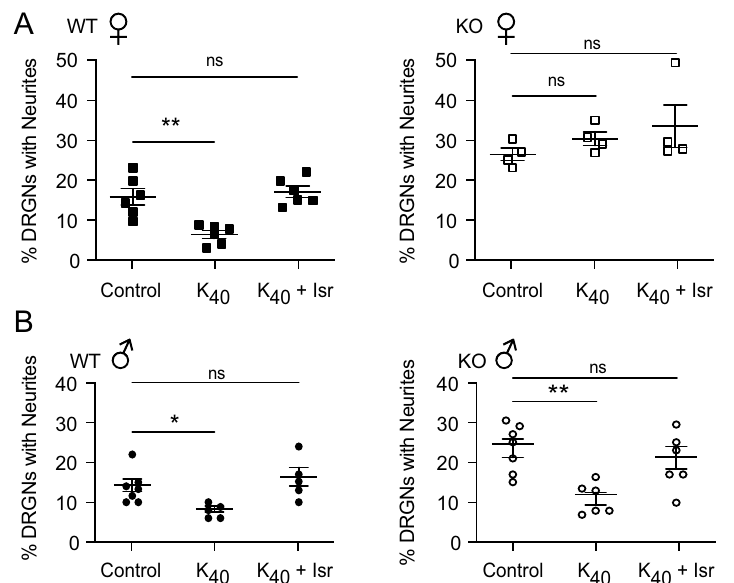
Figure 6. Caldendrin is required for Ca v 1-dependent repression of neurite growth in DRGNs of females but not males. ( A , B ) DRGNs were cultured for 18 h with or without 40 mM KCl (K 40 ) ± isradipine (Isr, 10 µM). Analysis of % DRGNs with neurites as in Fig. 5 in cultures from WT or caldendrin KO females ( A ) or males ( B ). Each point represents average determined from ~ 300 DRGNs per culture. Bars represent mean ± SEM. ( A ) F(2,15) = 14.69 ,** p = 0.001; F(2,9) = 1.13, p = 0.6;l ( B ) F(2,14) = 5.53 ,* p = 0.05; F(2,16) = 8.1 ,** p = 0.002, by one- way ANOVA with Dunnett’s multiple comparisons